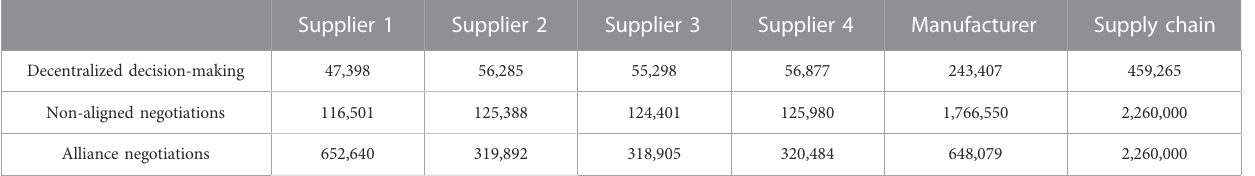
TABLE 2 Pro fi ts of suppliers and the